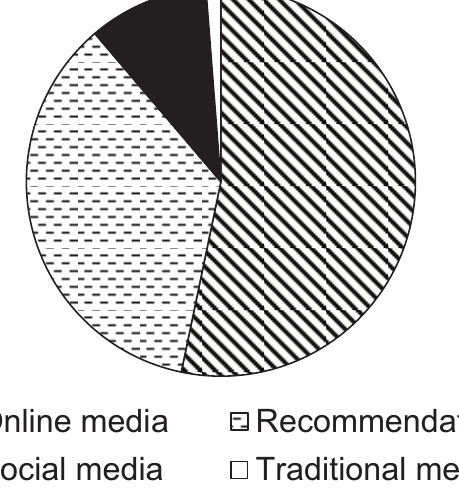
Figure 5 - Media in which the first contact with podcasts occurs, according to